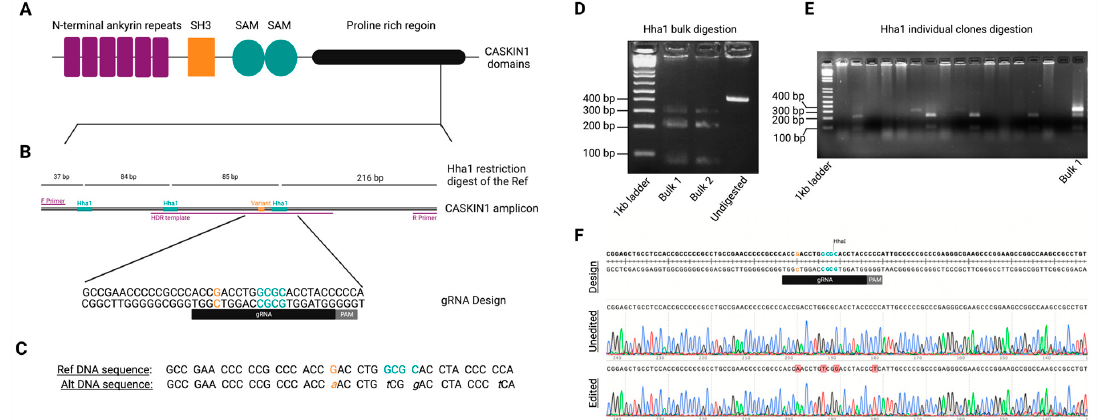
Figure 2. Successful editing of the proline ‐ rich region of CASKIN1 . ( A ) CASKIN1 protein domains. CASKIN1 D1204N is present in the C ‐ terminal proline ‐ rich region. ( B ) CASKIN1 amplicon depicts the PCR primers (purple) designed to capture the variant (orange) and 3 Hha1 (teal) sites. gRNA design shows the sgRNA (black) and PAM (grey) used to generate edits in the region. Top line captures the Hha1 restriction digest results for an unedited reference line. ( C ) Cell line DNA sequence before and after CRISPR editing. Editing abolishes Hha1 site. ( D ) Screen of a PCR followed by Hha1 restriction digest of two transfected wells. Successful editing is shown as two restriction digestion patterns, reflecting two populations of cells, edited and unedited. ( E ) Screen of clones derived from single ‐ cell cloning. Lane 3 shows a mixed population, lane 7 shows an edited clone and lane 11 shows an unedited clone. ( F ) Example sanger sequencing chromatogram of the cell line before and after editing.